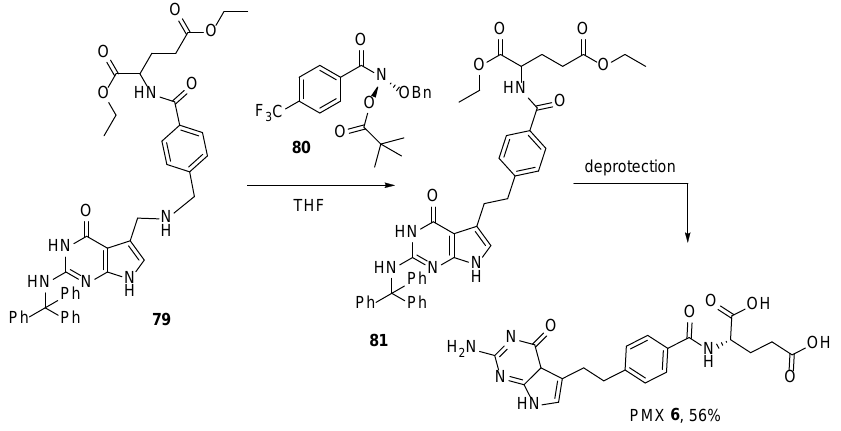
Scheme 27. Synthesis of Pemetrexed by the reaction of anomeric amide agent with secondary amine precursor followed by the deprotection of protective